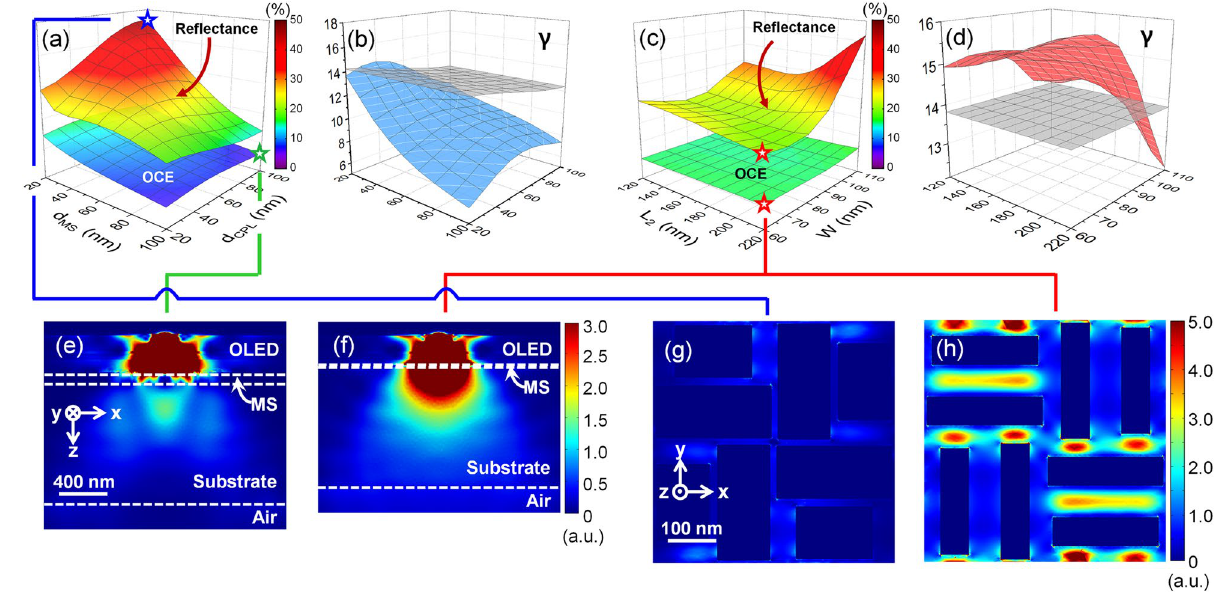
Figure 2. ( a ) OCE and the luminous reflectance while the thickness of CPL and MS is varied in the range of 20–100 nm. L 1 , L 2 , and W are fixed to 240, 160, and 110 nm, respectively. ( b ) Optimization factor ( γ ) of MIB- OLED (in blue) and conventional B-OLED (in gray) with respect to the thickness of CPL and MS in the range of 20–100 nm. ( c ) OCE and the luminous reflectance with respect to L 2 and W. L 2 and W are varied, respectively, in the range of 120–220 nm and 60–110 nm. ( d ) Optimization factor ( γ ) of the MIB-OLED (in red) and the conventional B-OLED (in gray). d CPL , d MS , and L 1 are fixed at 40, 20, and 240 nm. Due to the lack of MS in conventional B-OLED, γ remains as constant for conventional B-OLED along the d MS axis. Power flow of MIB- OLEDs: ( e ) spatial distribution in the zx plane for MS with L 1 = 240 nm, L 2 = 160 nm, W = 110 nm, d MS = 100 nm, and d CPL = 100 nm assuming horizontal dipole emission at y = 0. The parameter set is in ( a ) marked with a green star symbol. ( f ) For optimum MS with L 1 = 240 nm, L 2 = 220 nm, W = 60 nm, d MS = 20 nm, and d CPL = 40 nm, as marked in ( c ) with a red star symbol. ( g ) Spatial distribution in the xy plane by external light incidence ( λ = 550 nm) for MS with L 1 = 240 nm, L 2 = 160 nm, W = 110 nm, d MS = 20 nm, and d CPL = 100 nm, as marked in ( c ) with a blue star symbol, and ( h ) for the same optimum MS marked with a red star symbol in ( c